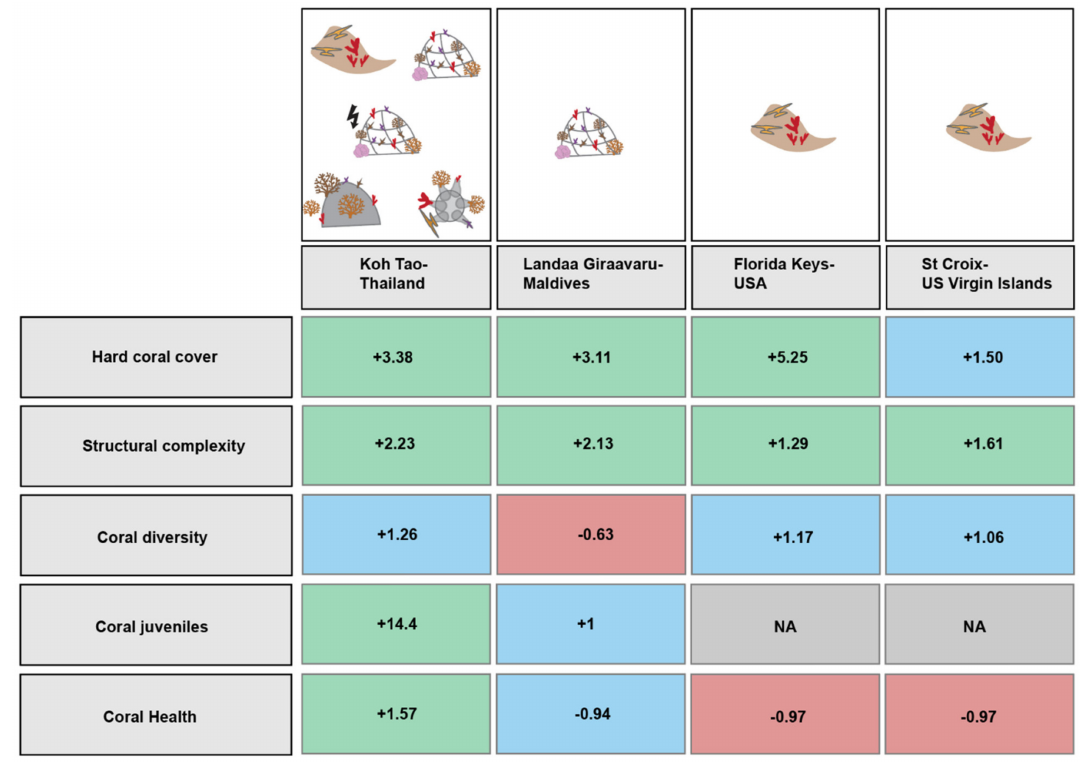
Figure 11. Summary table comparing five ecological indicators surveyed at four study locations with di ff erent restoration designs. Numerical values represent the ratios of each metric at restored compared to unrestored treatments. Colored boxes represent the significance of the di ff erence between restored and unrestored treatments. Green denotes significant positive ratios; red denotes significant negative ratios; blue denotes non-significant di ff